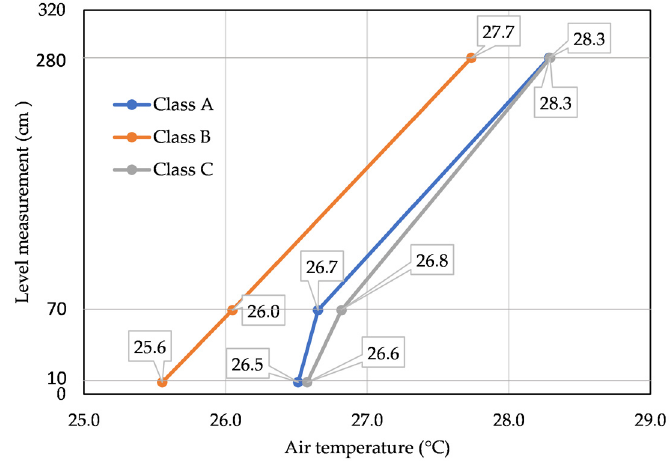
Figure 24. Average air temperature distribution per level measurement (10 cm, 70 cm, and 280 cm) in each classroom.